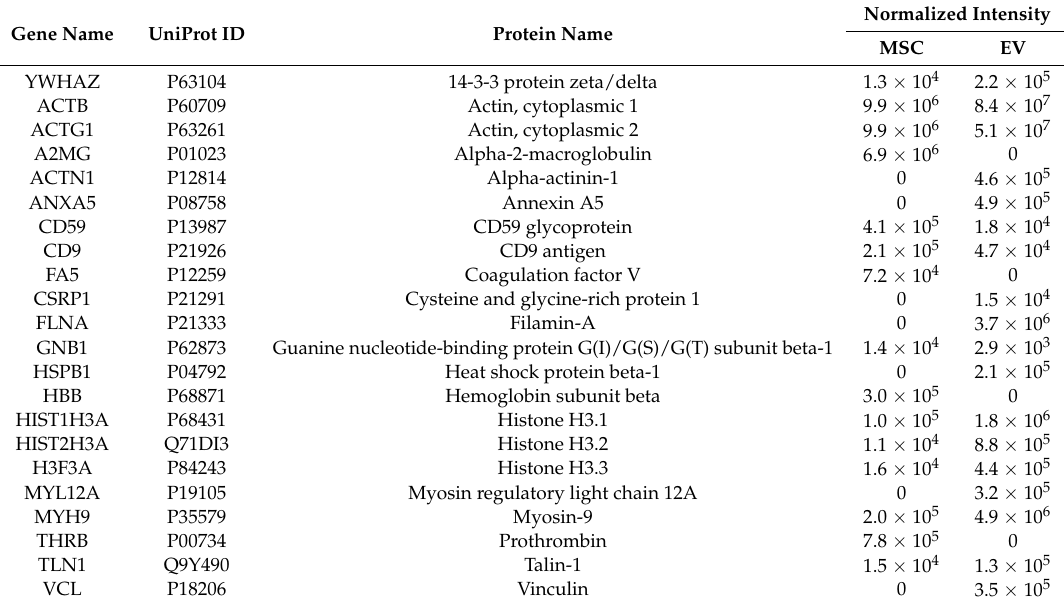
Table 1. MSC and EV proteins associated with blood